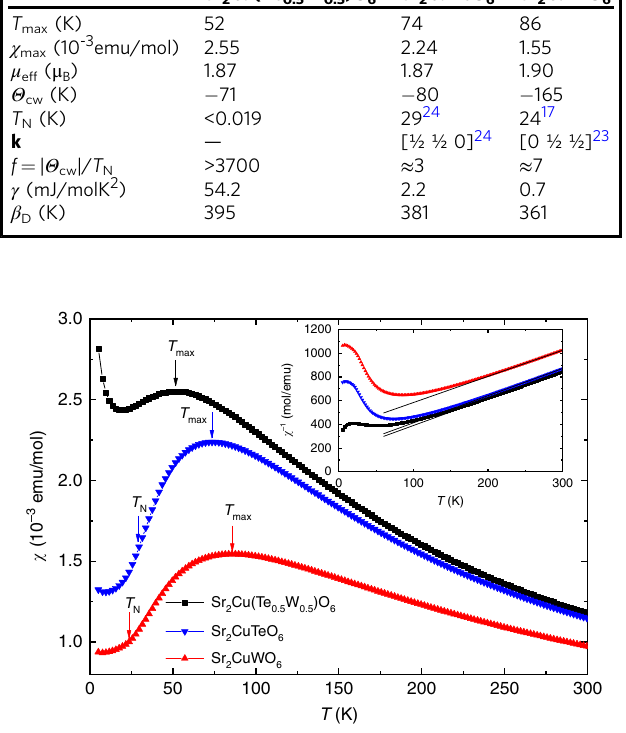
Fig. 2 Magnetic susceptibility. DC magnetic susceptibility of Sr 2 Cu(Te 0.5 W 0.5 )O 6 , Sr 2 CuTeO 6 and Sr 2 CuWO 6 measured in a 1 T fi eld. Néel temperatures of Sr with T max . Zero- fi eld cooled and fi eld cooled curves fully overlap and